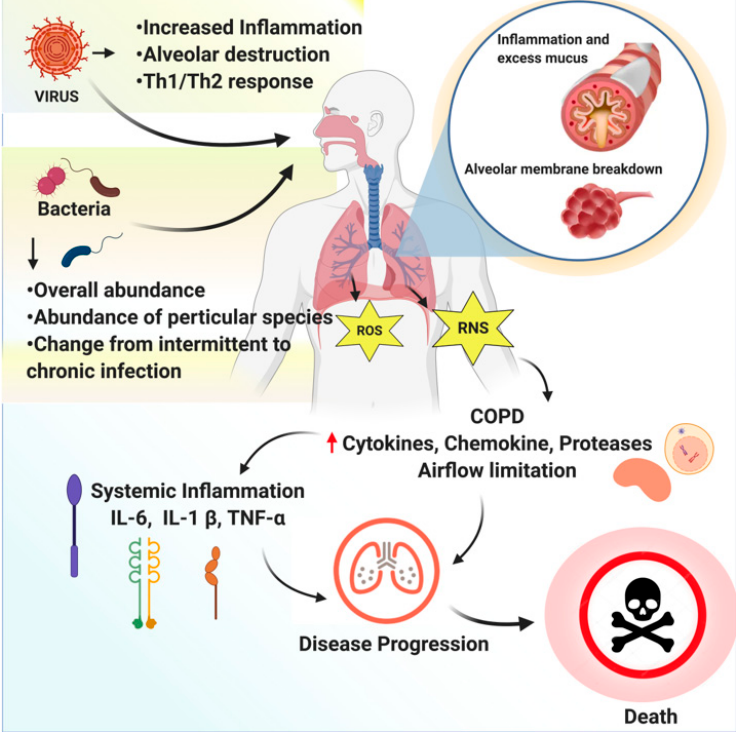
Figure 1. An overview of respiratory tract infections caused by bacteria and viruses. Respiratory pathogens increase the chance of intermittent to chronic lung infection by increasing inflammation and alveolar destruction. Generation of reactive oxygen species (ROS) and reactive nitrogen species (RNS) leads to increase cytokines, chemokines, protease, and limitation of airflow that induce the severity and progression of COPD, systemic inflammation, and lung disease progression and decrease patient survival.